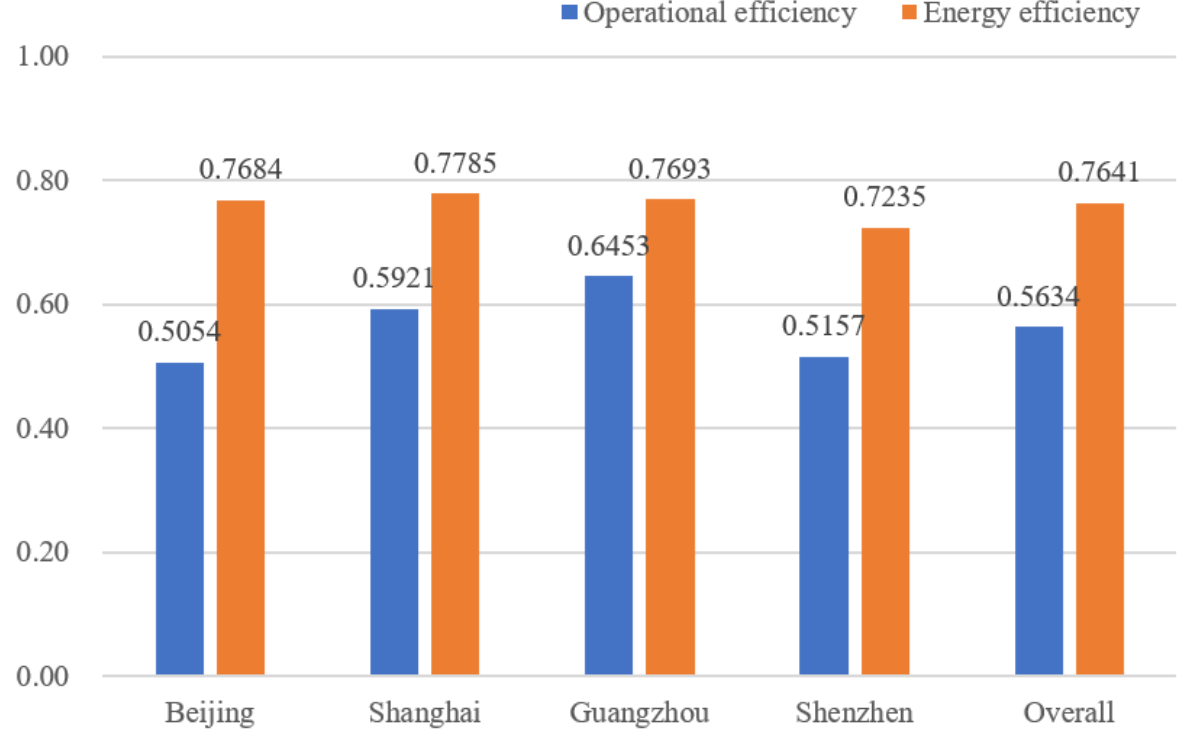
Figure 3. The average efficiency of the URT systems in case cities. In particular, it can be seen that around five-sixths of the URT lines are inefficient. In Beijing, the operational efficiencies of 2 out of 20 observed URT lines are efficient, another 3 lines are over the overall average level, and 15 lines are under the overall average